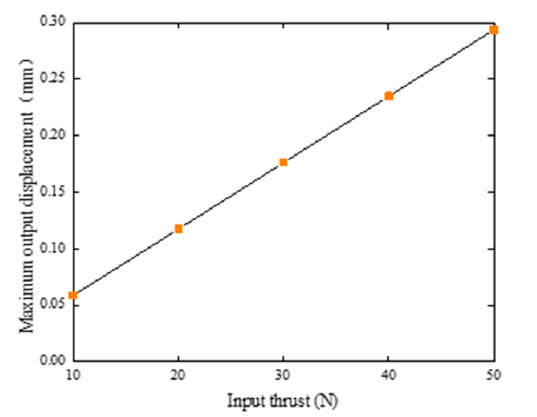
Figure 7. Relationship input thrust and maximum output displacement.